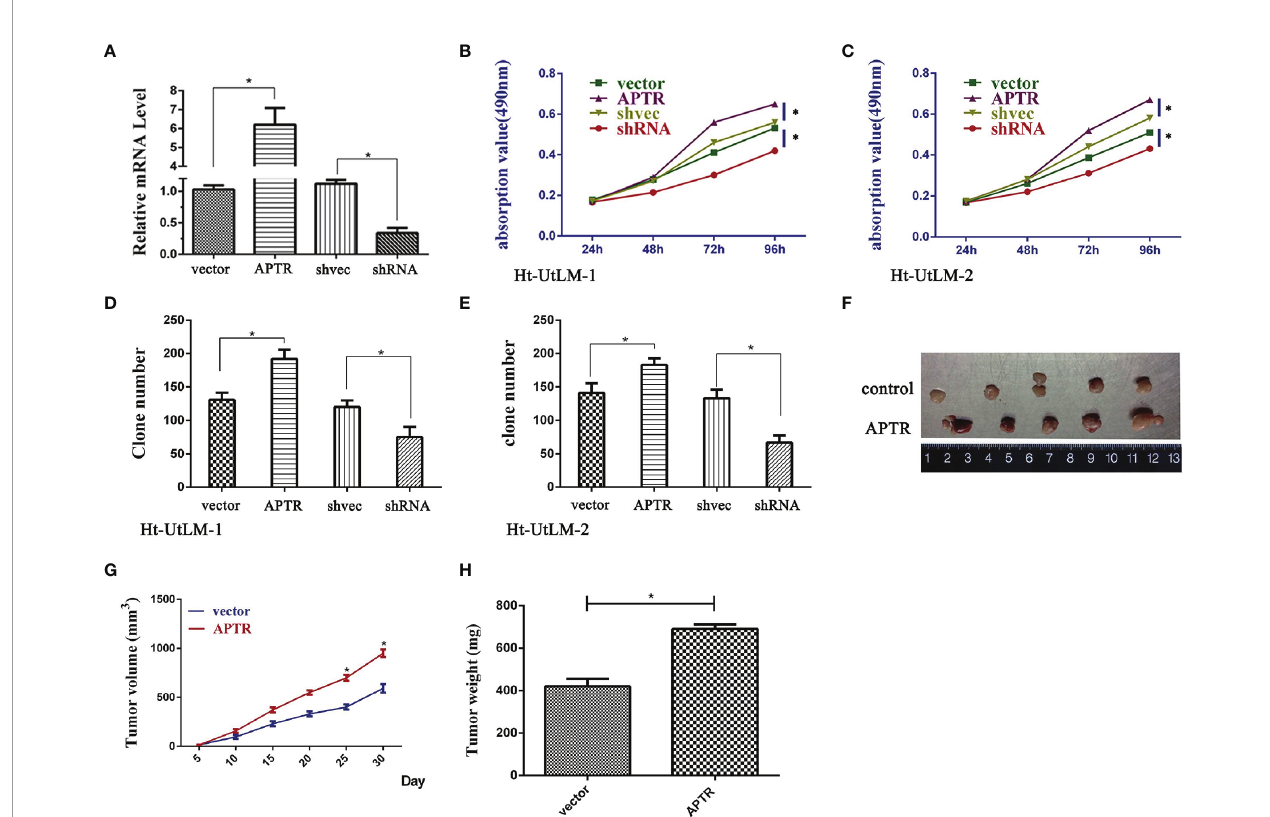
FIGURE 2 | LncRNA APTR induced leiomyoma tumor cell proliferation. Ht-UtLM primary cells derived from leiomyoma tumors were used. (A) Stably infected Ht- UtLM cells were generated and identi fi ed. Real-time PCR analyses con fi rmed the ef fi ciency. (B, C) Cell proliferation testing was conducted using MTT assays. APTR overexpression increased cell proliferation. Conversely, knocking down APTR decreased cell proliferation. (D, E) Colony-formation assays were performed on stably overexpressed or underexpressed APTR for 2 weeks. (F) Tumors from xenograft-transplanted nude mice 30 days after subcutaneously injecting APTR- overexpressing or control Ht-UtLM cells. (G) Xenograft volumes 30 days after cell injection. (H) Xenograft weights 30 days after cell